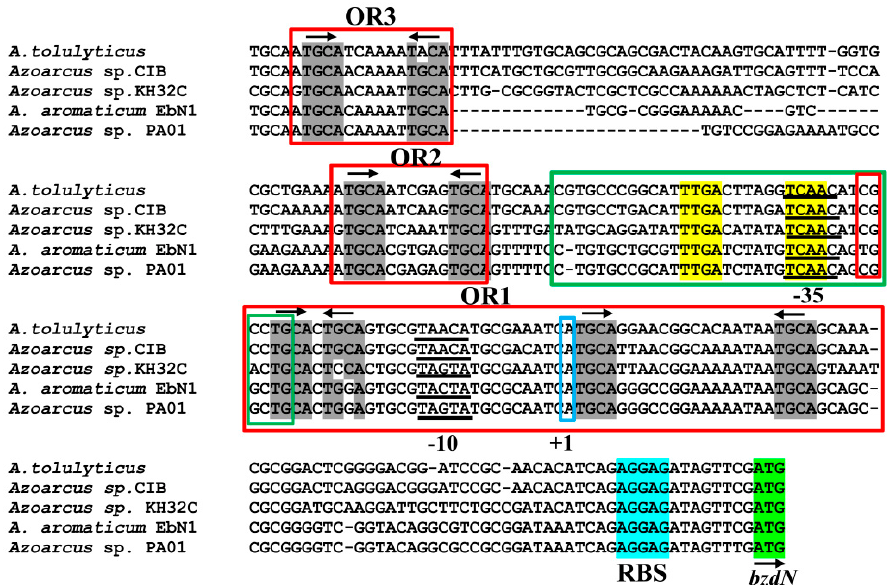
Figure 2. Sequence comparison analysis between the Azoarcus sp. CIB P N promoter [20] and the P N promoters from other Azoarcus / Aromatoleum strains. The sequence of the P N promoter from strain CIB spanning from position − 174 to + 79, with respect to the transcription start site ( + 1, indicated) is shown and compared with that of P N promoters from other Azoarcus strains. The σ 70 -RNA polymerase (RNAP) recognition sequences − 10 and − 35 are underlined, the ribosome-binding sequence (RBS) is marked in cyan, and the ATG initiation codon of the bzdN gene is shown in green. The operator regions I, II, and III (OR1, OR2, and OR3), involved in the interaction with the BzdR protein, are boxed in red. The arrows indicate the palindromic TGCA sequences (in gray) present in each of the operator regions. The green box shows the AcpR-binding region (palindromic sequences are indicated in